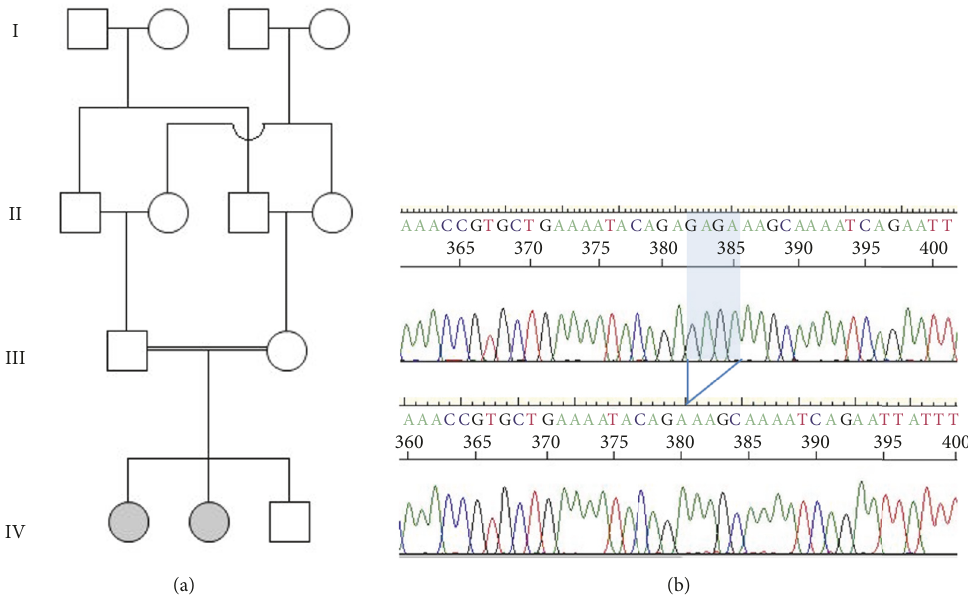
Figure 1: (a) Consanguineous Omani family segregating cerebellar atrophy, ataxia, coarse facial features, and intellectual disability. Arrow indicates index patient (IV-1). (b) Sanger sequencing chromatogram for reference (top panel) and index (bottom) showing the SNX14:c.2319 2322del pathogenic mutation (blue shade). The nature and zygosity status of the c.2319 2322del mutation segregating within this family is confirmed.